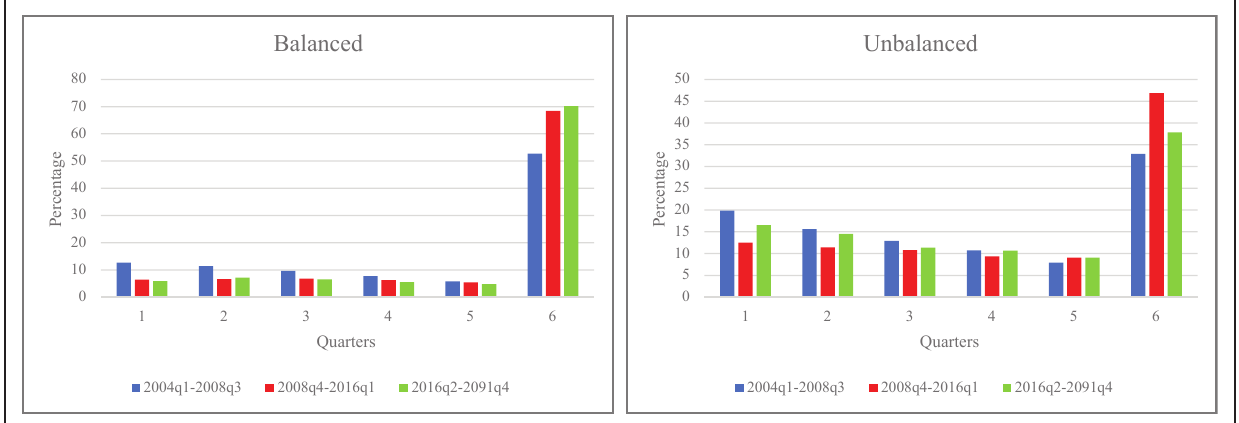
Total quarters in unemployment split in three periods (balanced versus unbalanced